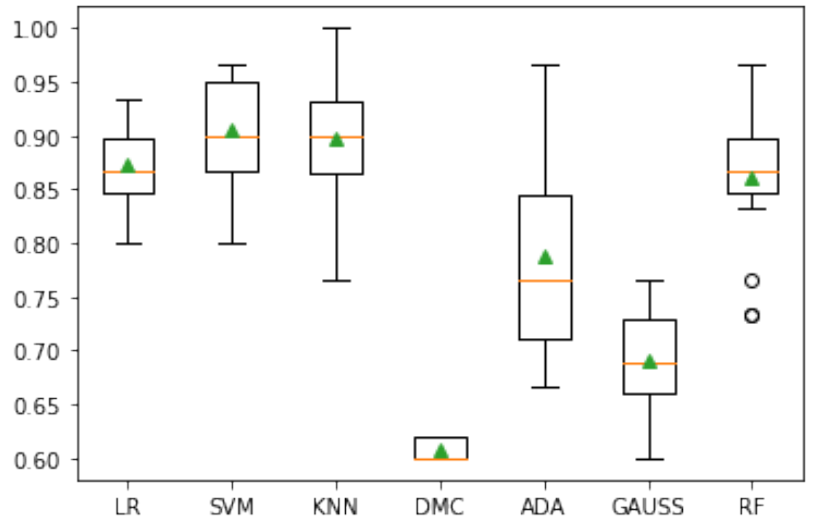
Figure 7. Comparison of the overall accuracy metric for different classifiers during the training phase of the unbalanced model. Note: The orange horizontal line refers to the median and the green triangle to the mean of the indicator.